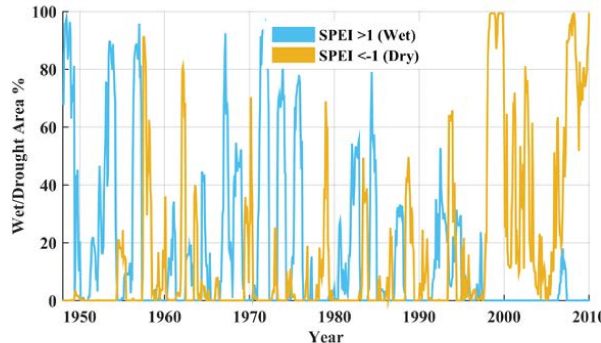
Figure 3. Temporal variations of monthly drought (SPEI < − 1) and wet (SPEI > 1) extent over